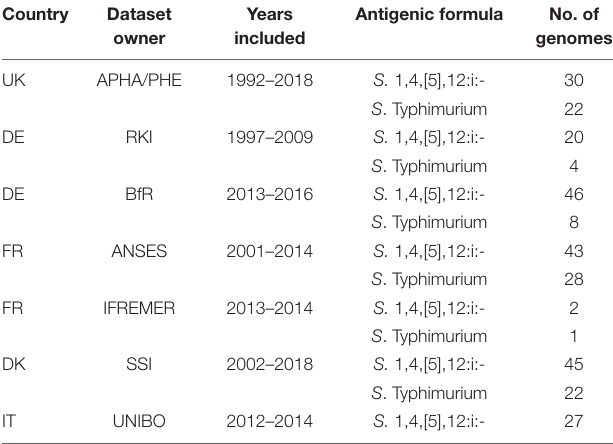
TABLE 1 | Overview of the dataset